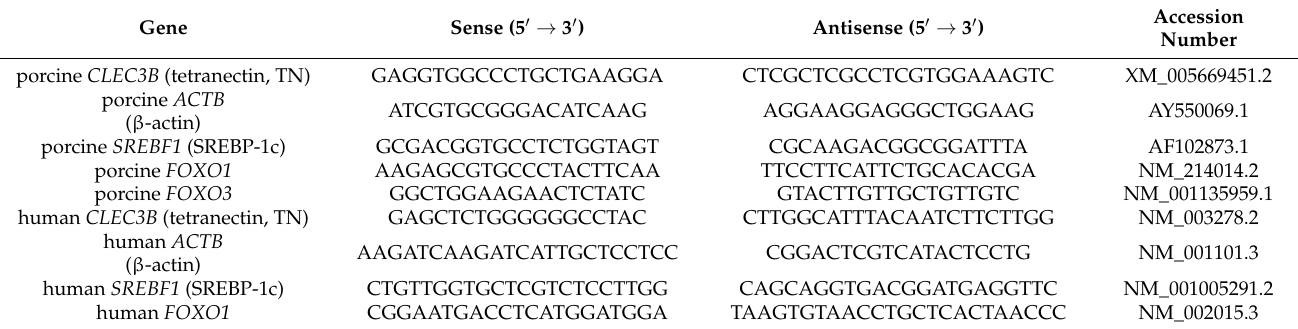
Table 3. List of primers for gene expression by quantitative real-time PCR analysis. Gene Sense (5 (cid:48) → 3 (cid:48)